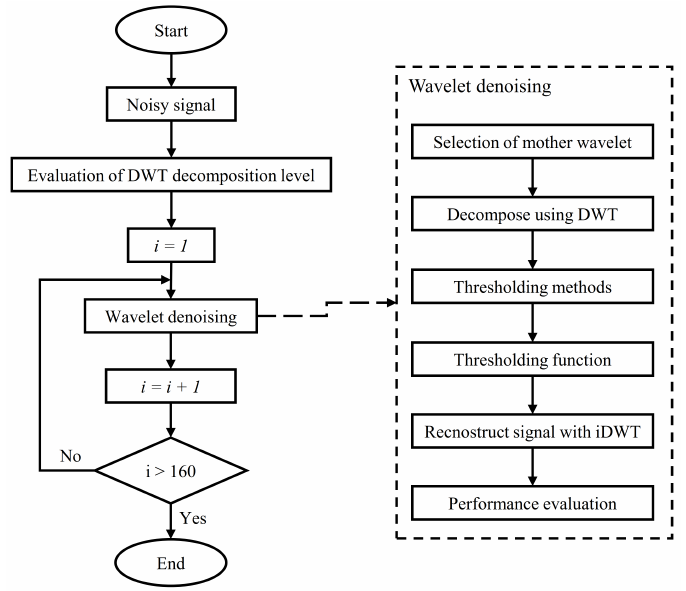
Figure 1. Algorithm flow chart for the parameter screening of the proposed DWT